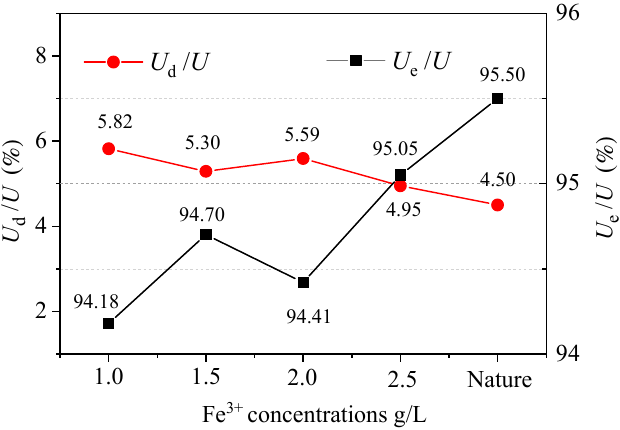
Figure 4. Relationship between sample energies and concentrations. After chemical etching with the solution concentration, the peak of the strain energy value was less, suggesting that the soaking process by dissolution increased the internal damage of the sample. With the corrosion effect, the internal damage became more severe and more likely to cause new damage. At the same time, the internal part of the rock min- erals affected by the chemical changes reduced the brittleness of the samples [53–55]. From